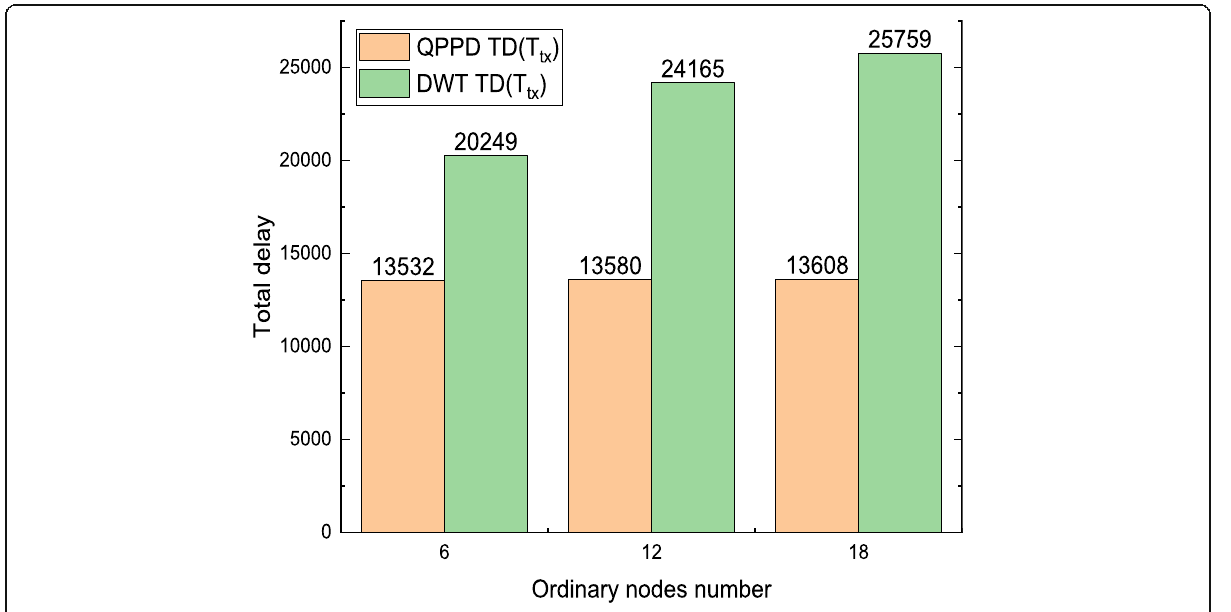
Fig. 27 The total volume of data is equal to 3 in each cycle; the total delay